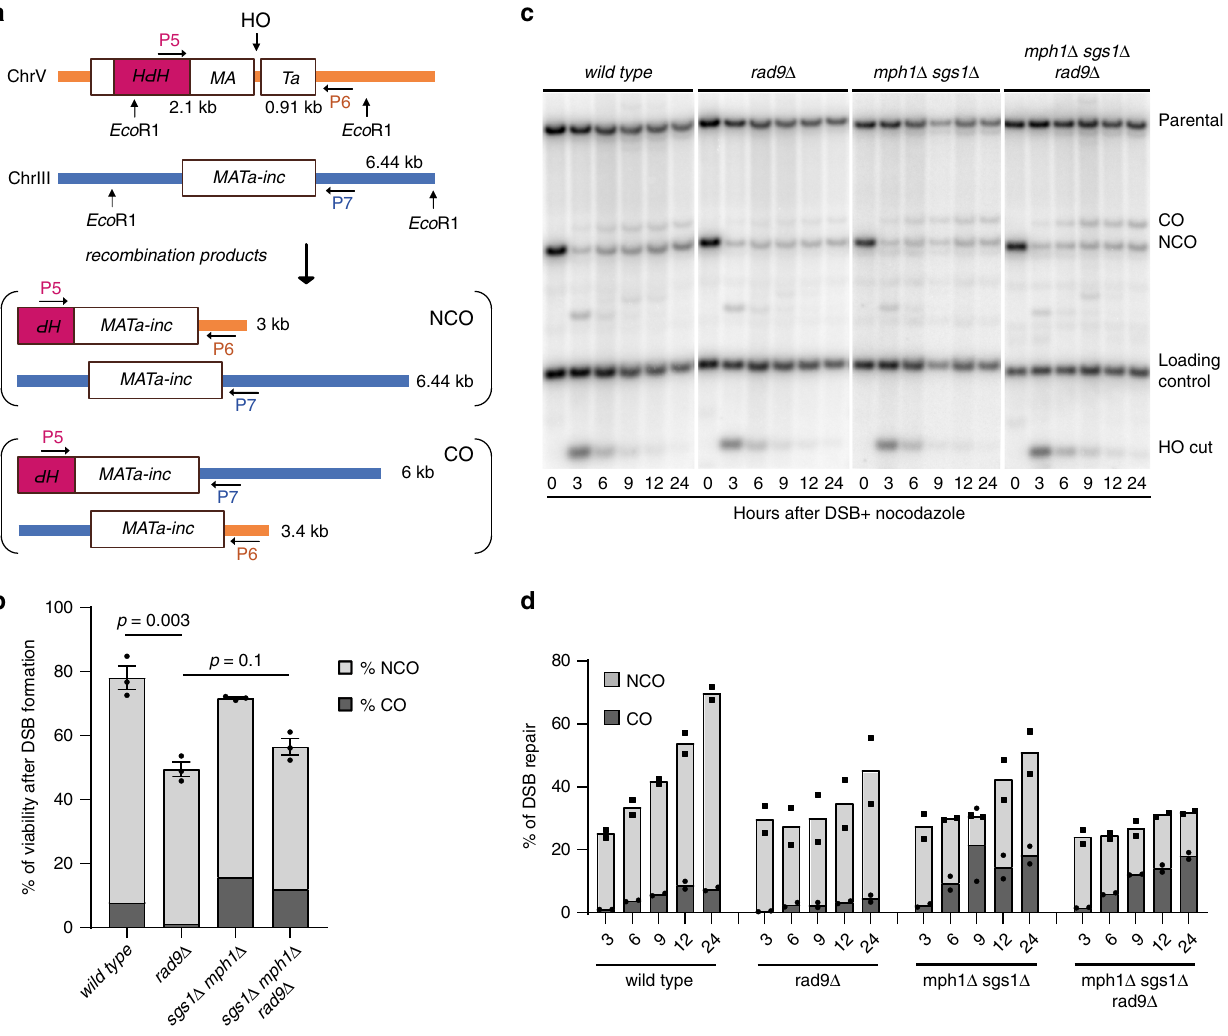
Fig. 6 Limiting Sgs1-Mph1 by Rad9 promotes CO in ectopic DSB repair. a Scheme of the genetic system to test ectopic gene conversion (eGC) in tGI354 background. b Cell viability after DSB in the indicated tGI354 derivative strains ( n = 3 independent experiments) combined with the frequency of crossovers (CO) and non-crossovers (NCO) in the survivors measured by PCR analysis. c Southern blot of Eco RI-digested DNA to monitor DSB repair through eGC in the indicated tGI354 derivative strains. CO crossover, NCO non-crossover. d Densitometric analysis of the CO and NCO bands of two biologically independent experiments as in ( c ). All the data in the fi gure are presented as mean ± SEM wherever n = 3 or more. Statistical analysis was performed using unpaired two-tailed Student ’ s t -test. See accompanying Source data fi